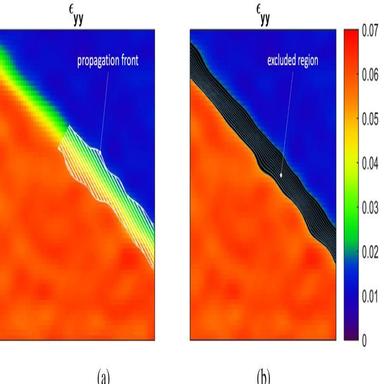
Propagation of the front of phase transition observed in a generic ROI between two successive images, superposed to the region of gradual strain variation predicted by the DIC technique (a); and strain map after exclusion of the transition region (b).